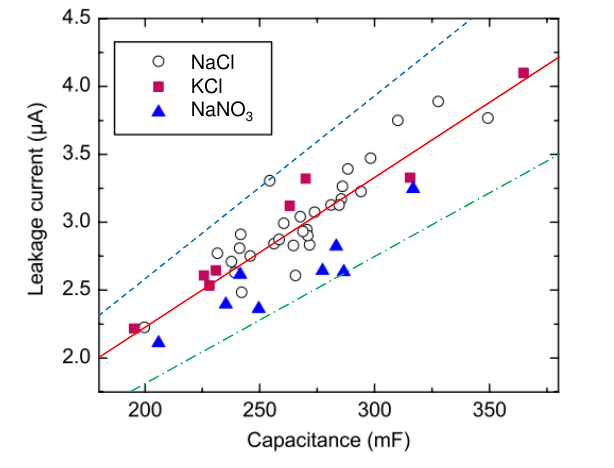
Figure 2. Leakage current behavior with respect to supercapacitor capacitance introduced in [18]. Corresponding median fitted line with I l ≈ 1.11 × 10 − 5 C s (—), is shown and additionally upper limit behavior I l ,up ≈ 1.31 × 10 − 5 C s (- - -) and lower limit behavior I l ,low ≈ 0.929 × 10 − 5 C s (- . - . -) may be